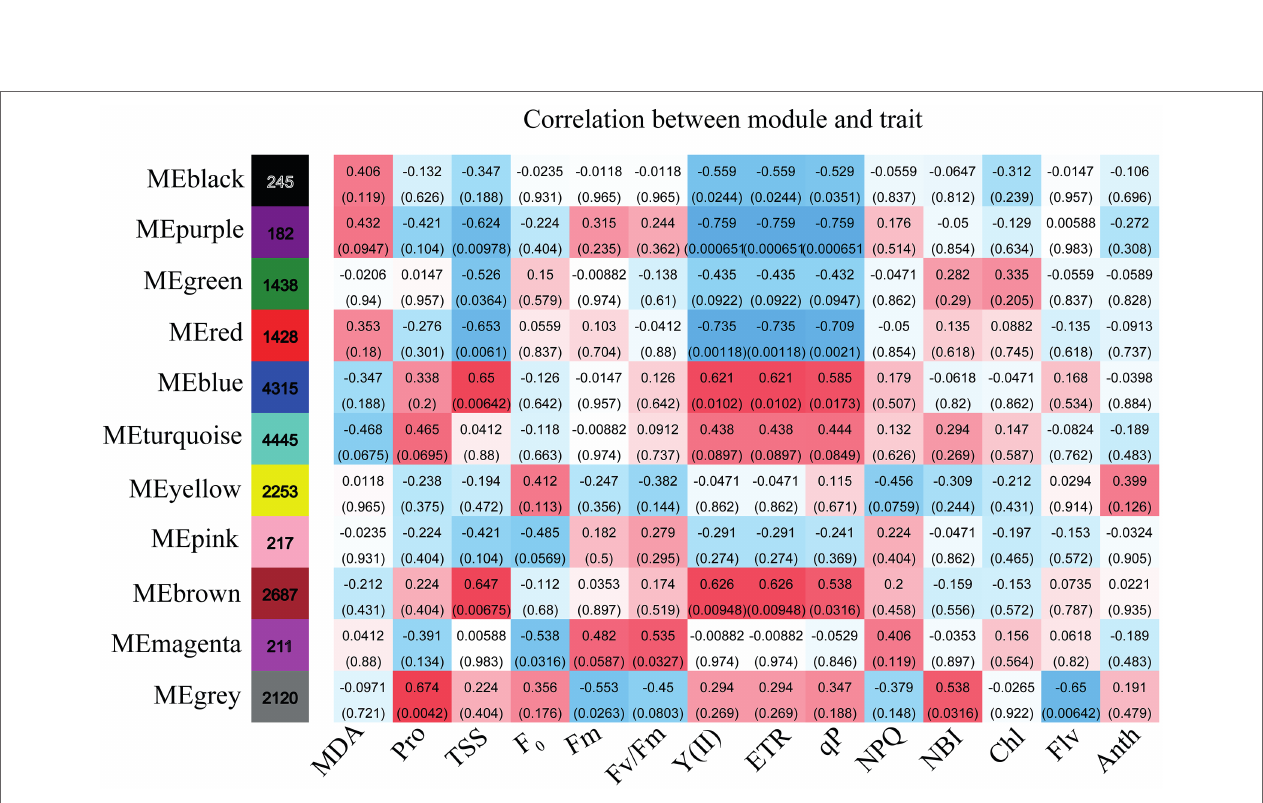
FIGURE 4 | The significant differentially expressed unigenes was significant enrichened of KEGG pathways. The (A) is the up- and down-regulated differentially expressed unigenes of D2 and D3 verse CK. The (B) is the up-regulated differentially expressed unigenes of D3 verse CK. The color was showed the expression values (log 10 (TPM)), and the red represent high TPM. The figures were visualized by TBtools.